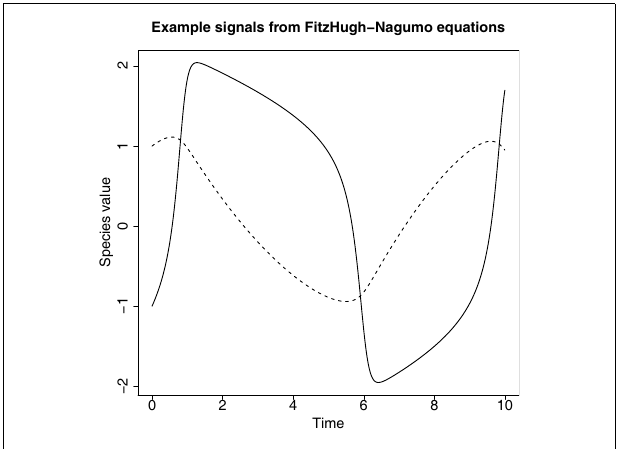
FIGURE 4 | An example of the signals produced from the FitzHugh–Nagumo ODEs in equation (62) . The solid line represents the signal for species V and the dashed line represents the signal for species R.